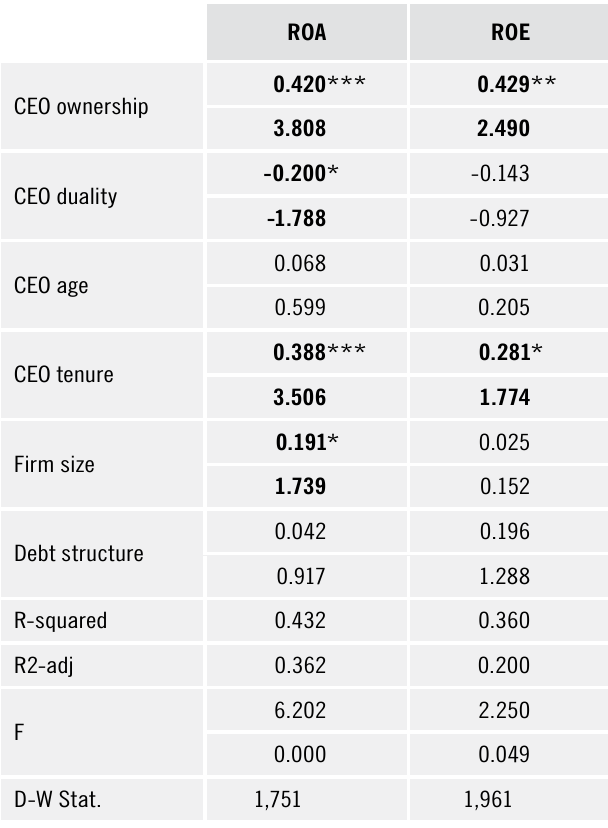
Table 11. Regression